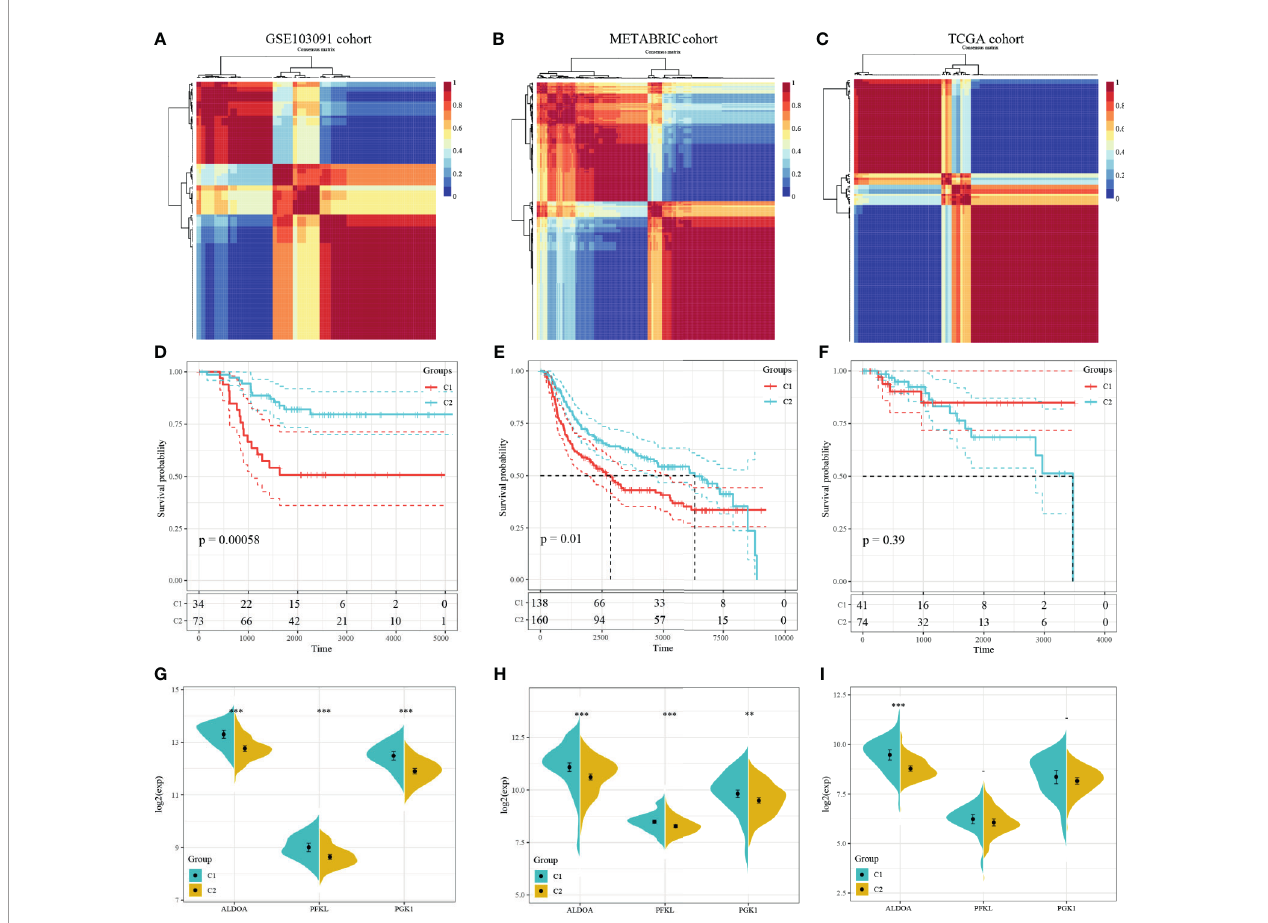
FIGURE 4 | Identi fi cation and validation of an HRG-based molecular classi fi cation of TNBC patients using the nonnegative matrix factorization (NMF). Consensus clustering matrix for k = 2 – 10, which was the optimal cluster number in the GSE103901 cohort (A) , METABRIC cohort (B) , and TCGA-TNBC cohort (C) . Kaplan – Meier (K – M) survival analyses of the patients in Cluster 1 and Cluster 2 subgroups in the GSE103901 cohort (D) , METABRIC cohort (E) , and TCGA- TNBC (F) , which indicated that the patients in Cluster 1 had poorer OS than those in Cluster 2. The expression patterns of the three HRGs included in the hypoxia signature between two clusters of TNBC patients in the GSE103901 cohort (G) , METABRIC (H) , and TCGA-TNBC (I) . (**represents p < 0.01, ***represents p <